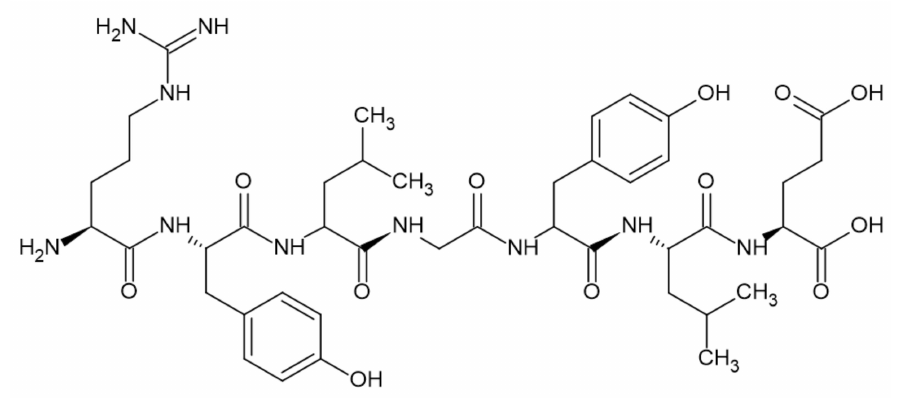
Figure 12. The structure of casein [48].